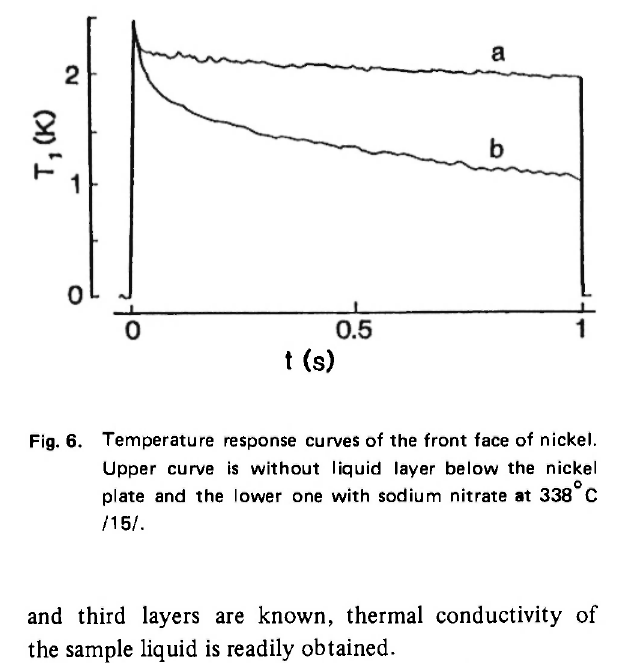
Fig. 6. Temperature response curves of the front face of nickel. Upper curve is without liquid layer below the nickel ο plate and the lower one with sodium nitrate at 338 C /15/.